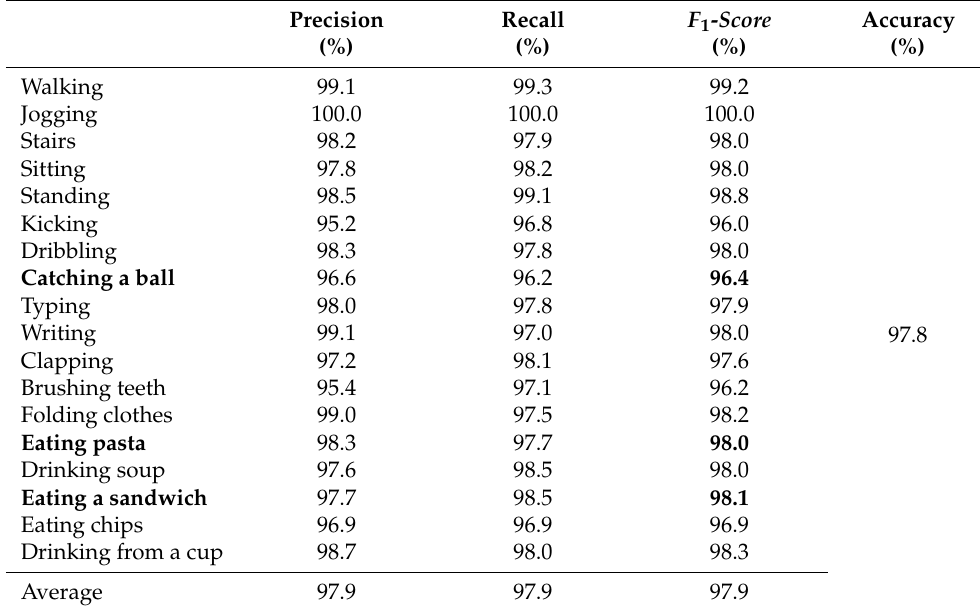
Table 6. The performances of SLFN with the ELM algorithm for 18 types of physical activities.